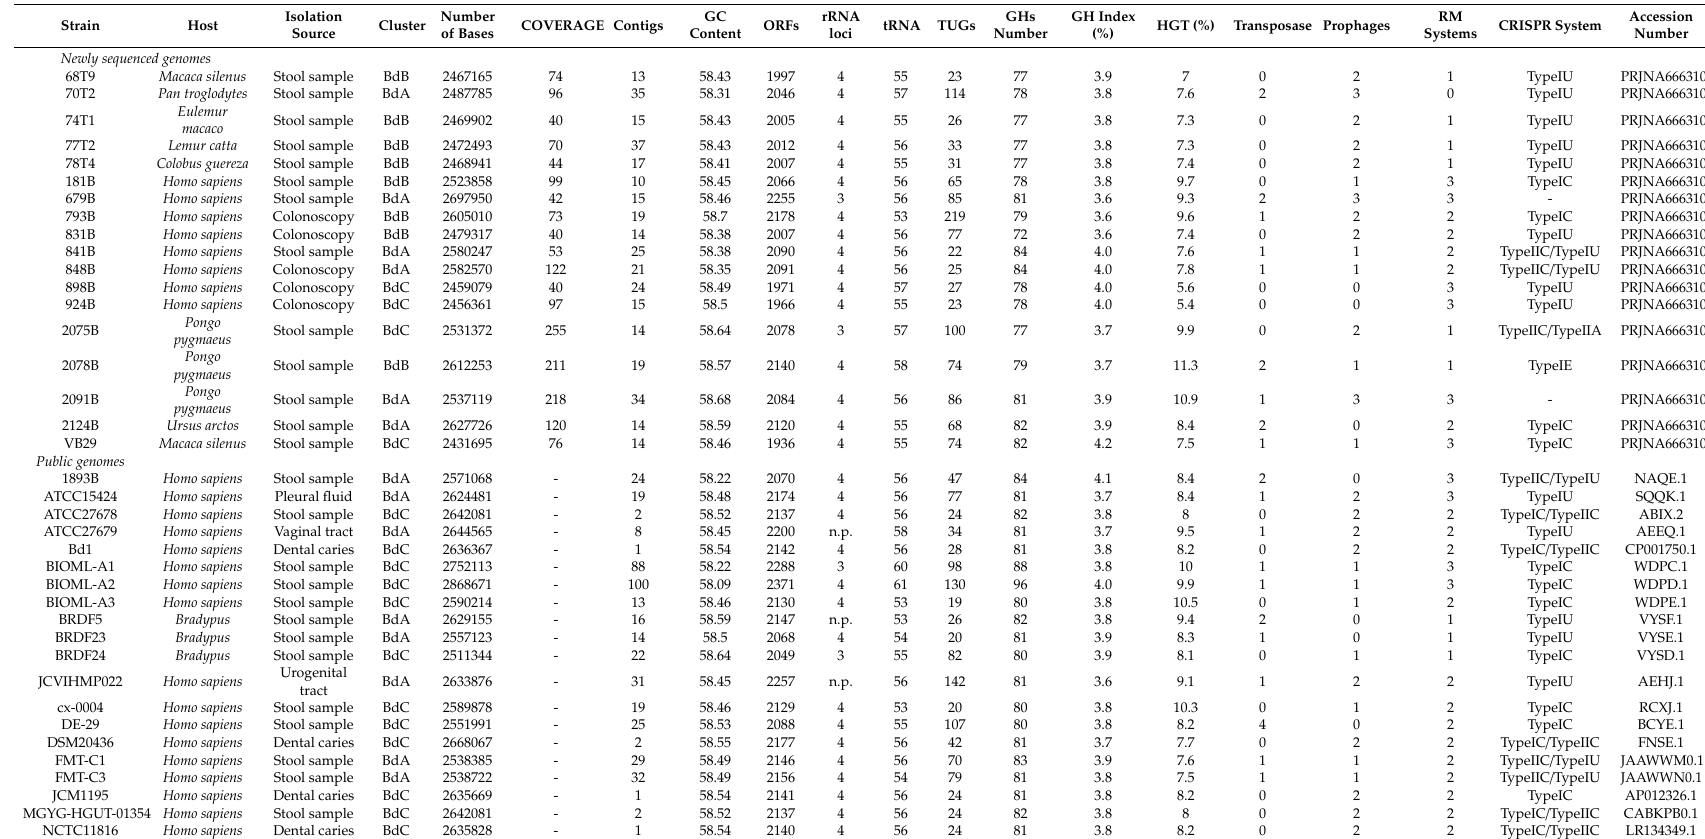
Table 1. General genome features of B. dentium